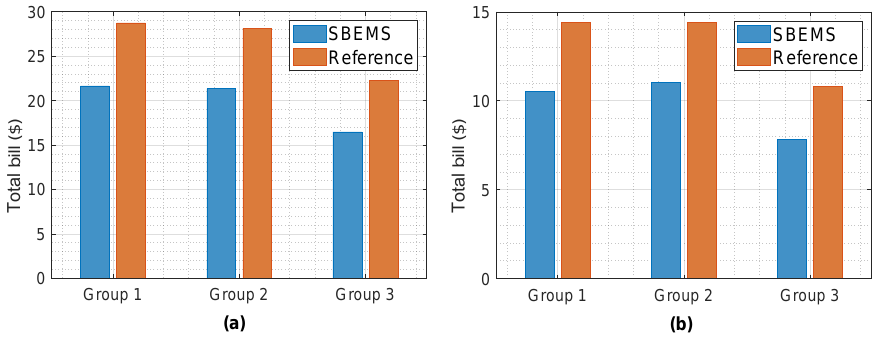
Figure 6. Electricity bill of 3 groups: ( a ) weekday, ( b )